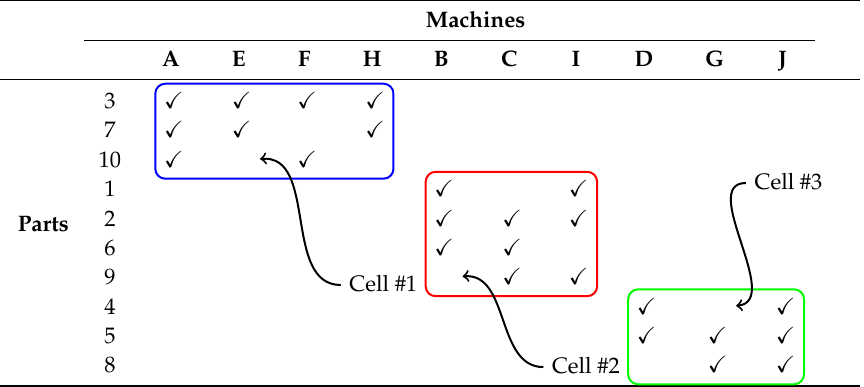
Table 3. Problem example. Optimized machine-cell and part-cell matrices.